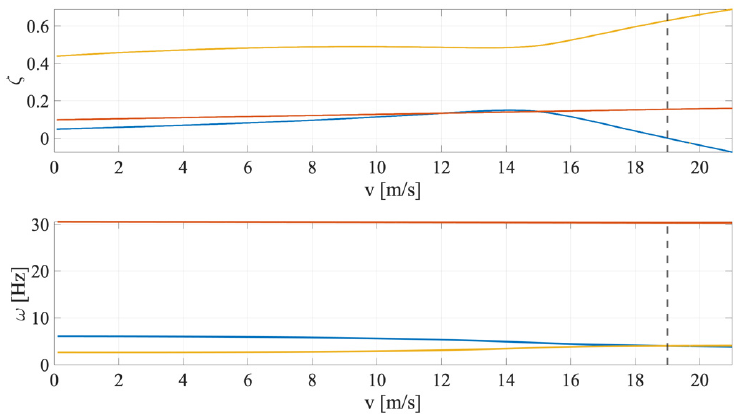
Figure 8. Damping ratio and frequency variations with the airstream velocity.